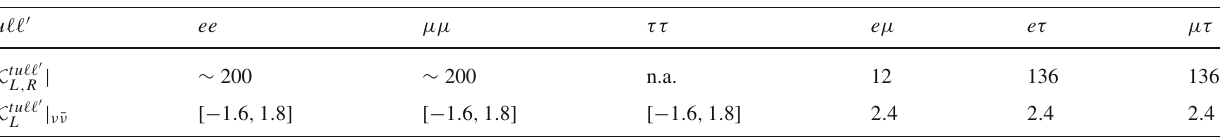
body rare B -decays to dineutrinos (bottom row). Numbers correspond from col- A to a limit on the modulus except when a range is given. LFV-bounds (cid:9) | K (cid:4) + (cid:4) (cid:2)− | 2 + | K (cid:4) − (cid:4) (cid:2)+ | derived from three- are quoted as flavor-summed, L